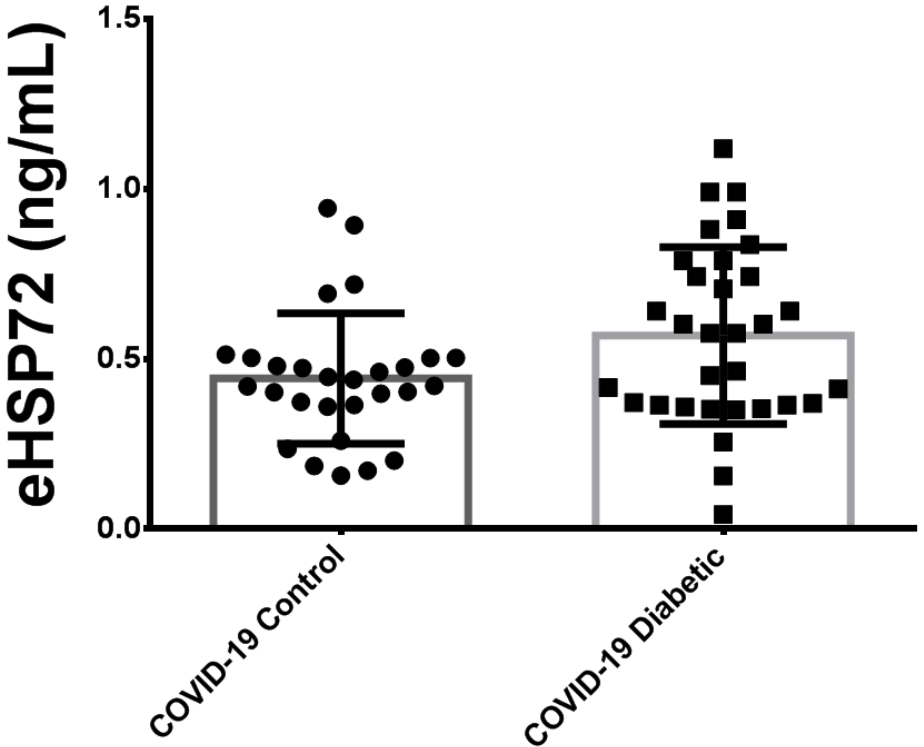
Figure 1. Comparison of plasma concentration of eHSP72 between critically ill patients with COVID-19 pneumonia with and without diabetes.